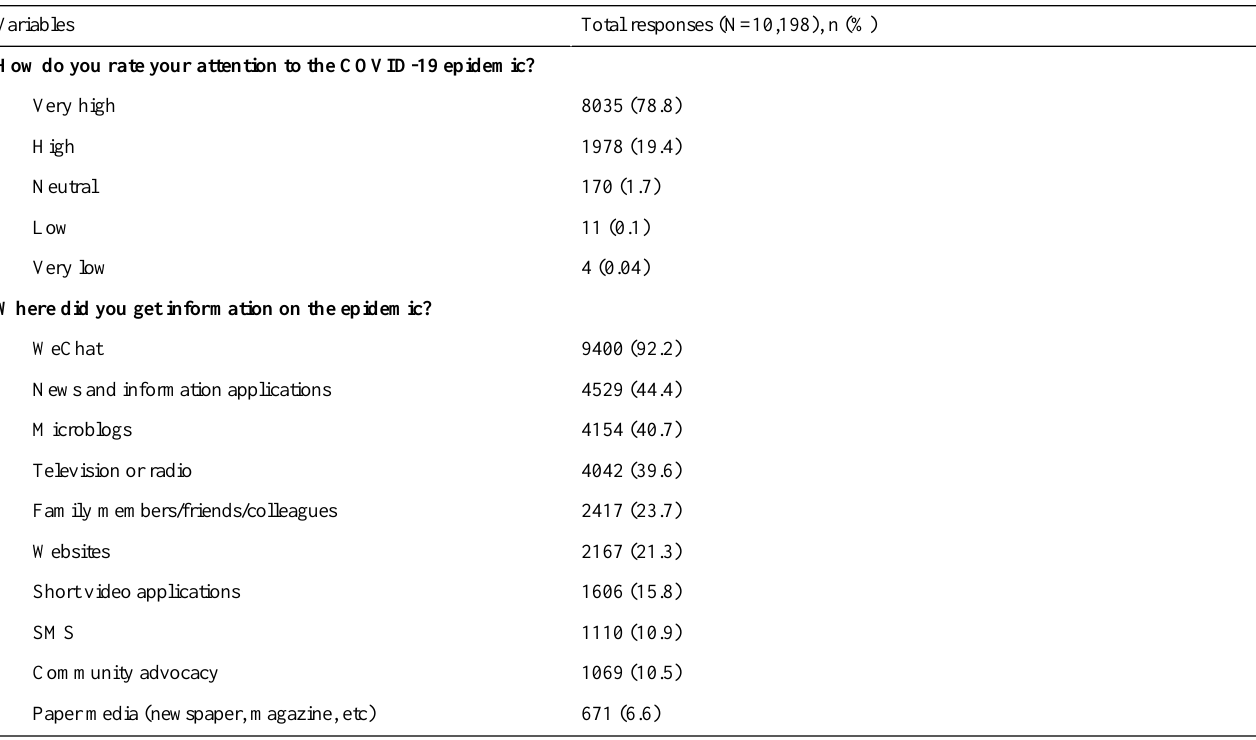
Table 2. Chinese citizens’level of attention to the coronavirus disease (COVID-19) epidemic and their main information sources. Total responses (N=10,198), n (%)Variables How do you rate your attention to the COVID-19 epidemic?